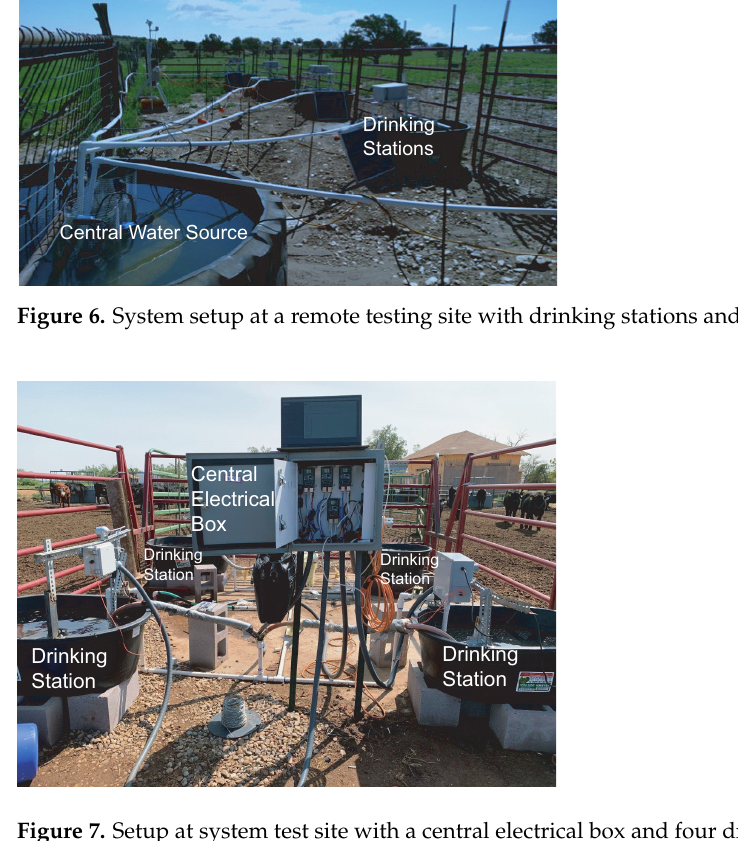
Figure 7. Setup at system test site with a central electrical box and four drinking